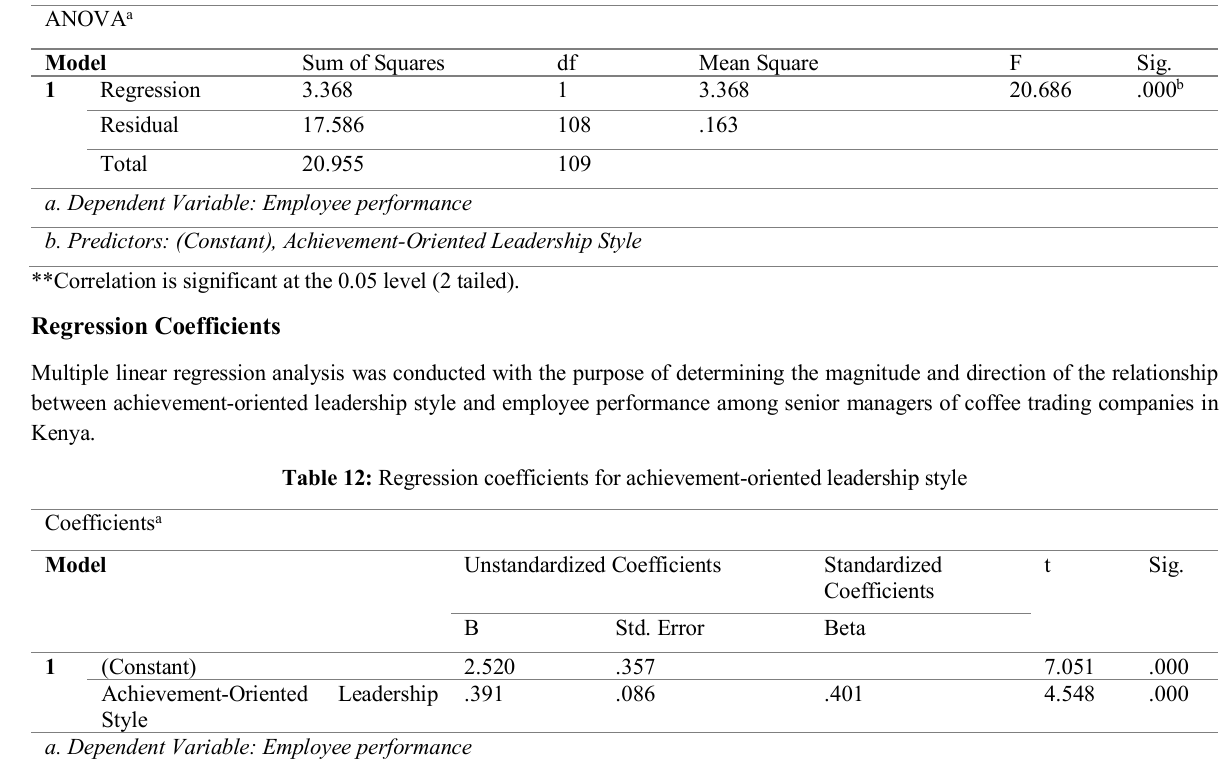
Table 11: Regression ANOVA for Achievement-Oriented Leadership Style